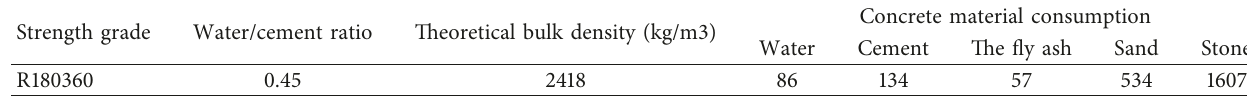
Table 2: The parameters of different compositions of the concrete.